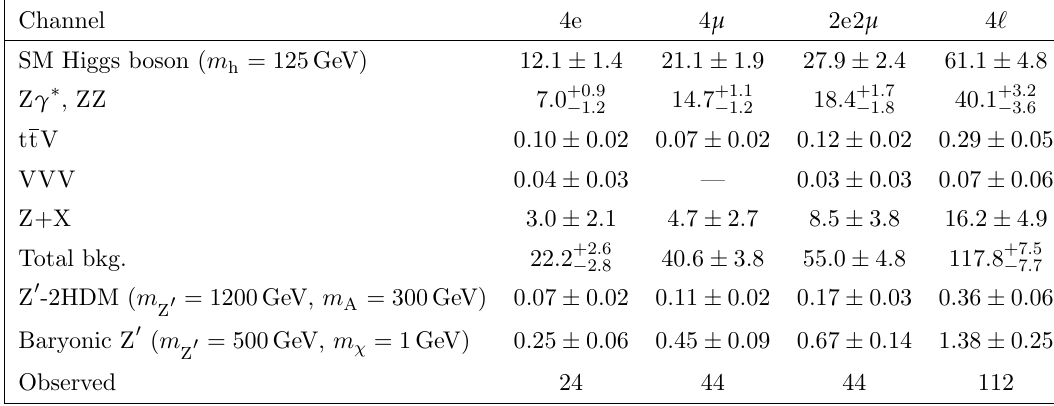
Table 7 . The post-(cid:12)t signal and background event yields, and the observed number of events in data, for the h ZZ analysis. The expected numbers of signal events for the two signal hypotheses ! are also reported, one for each benchmark model. The total uncertainty, including both statistical and systematic components, is quoted for the expected signal and backgrounds yields.